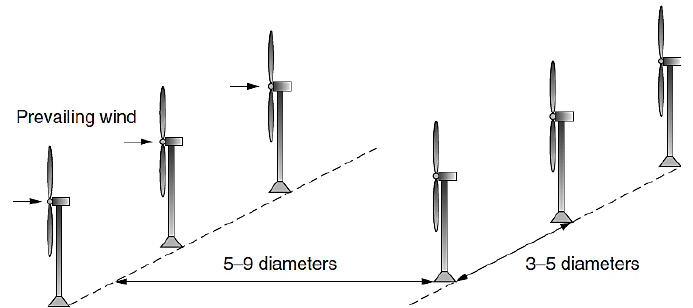
Figure 1. Estimated optimum spacing of towers of three - five rotor diameters between wind turbine generators within a row and 5 – 9 diameters between rows.